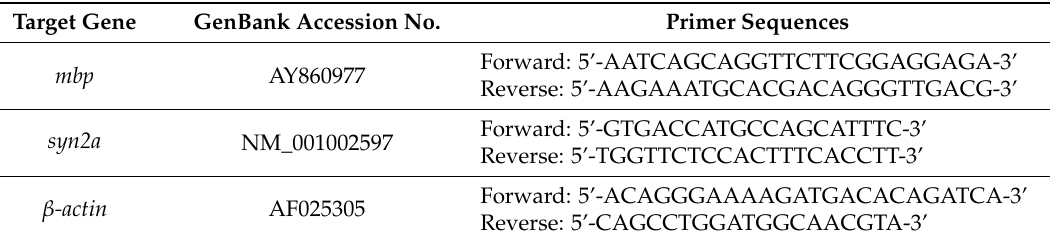
Table 1. Sequences of primers for the genes